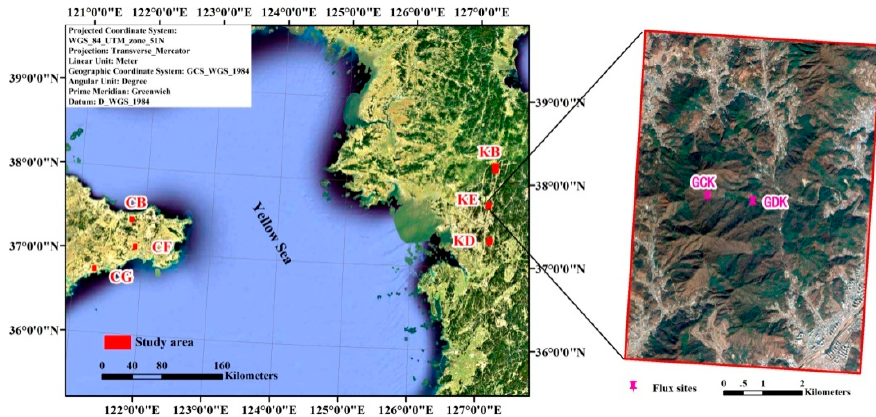
Figure 1. Location of the study area.